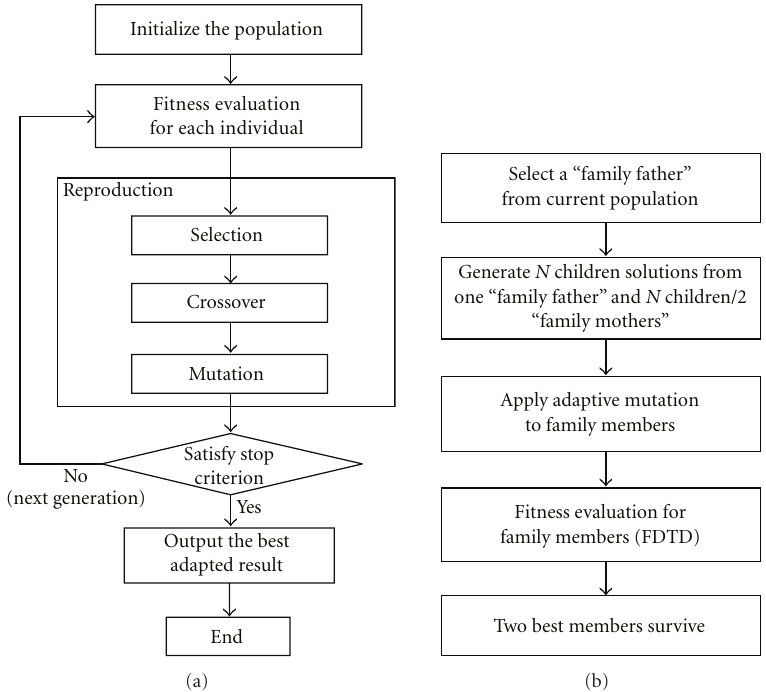
Figure 1: Flowchart for (a) the GA and (b) the family competition in the reproduction process of the FCGA.